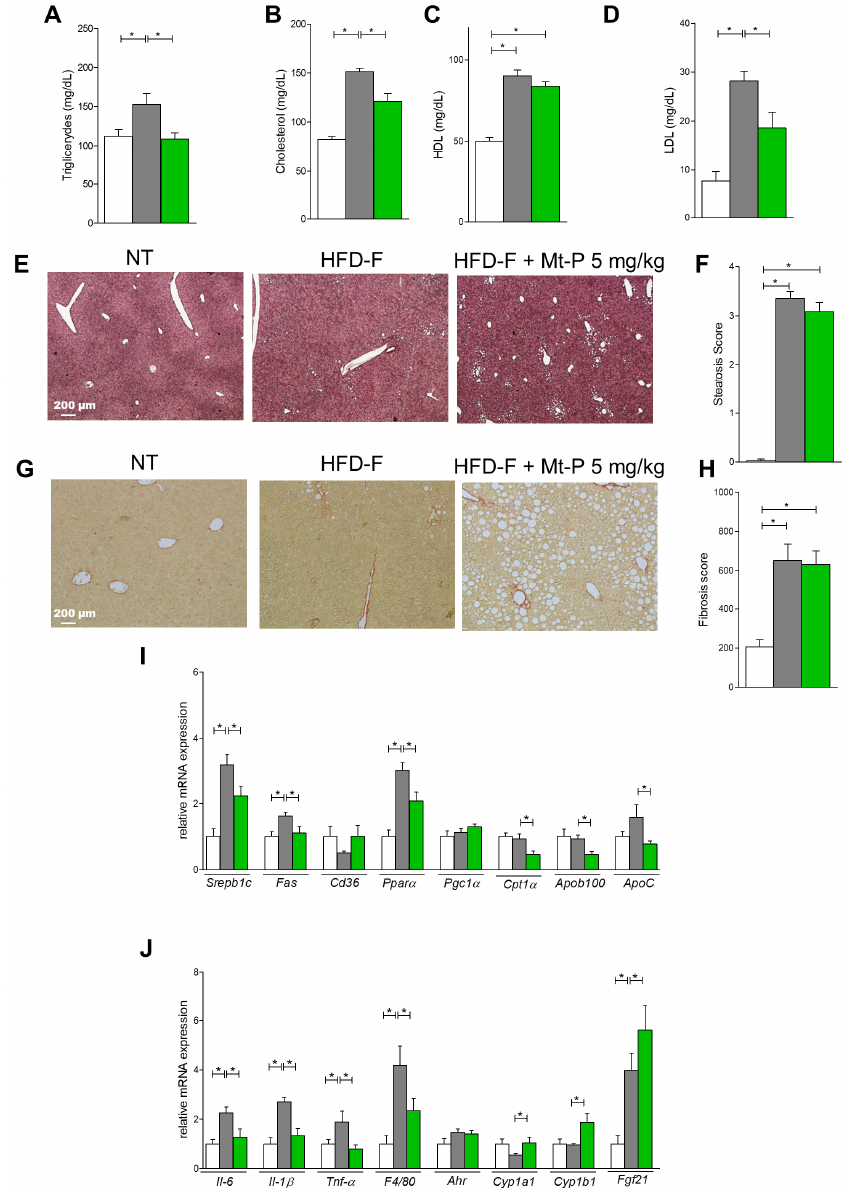
Figure 9. AhR activation exacerbated NASH-like features and fibrosis induced by HFD-F exposure. C57BL/6 male mice were fed a high fat diet (HFD) and fructose or normal chow diet as described before (see Section 2). Serum levels of ( A ) cholesterol, ( B ) triglycerides, ( C ) high density lipoproteins (HDLs), and ( D ) low density lipoproteins (LDLs). Biochemistry values were measured at the end of the study. ( E ) Hematoxylin and eosin (H&E) staining of liver tissues obtained at the end of the study (Magnification 4×). NASH severity was scored by assessing the ( F ) steatosis (NAS) score in at least five different fields per liver in a blind manner. ( G ) Sirius red staining of liver tissues obtained at the end of the study (Magnification 10×). ( H ) Liver fibrosis score (% collagen deposition) was measured, as described in Material and Methods, by ImageJ analysis. The images shown in panels ( E – H ) are representative of at least 10 others, each one obtained from an individual mouse, showing a similar pattern of regulation. Hepatic expression of ( I ) genes involved in the regulation of lipid synthesis ( Srebp1c, Fas ), fatty acids oxidation ( Ppar α , Pgc1 α , Cpt1 α ), and very low-density lipoprotein (VLDL) formation ( Apo100B, ApoC ), and ( J ) pro-inflammatory genes ( Il-6, Tnf α , Il-1 β , F4 / 80 ) and Ahr-target genes ( Ahr, Cyp1a1, Cyp1b1, Fgf21 ). Values are normalized relative to Gapdh mRNA and are expressed as mean ± SEM of six / ten mice per group (NT = 6; HFD-F = 8; HFD-F + Mt-P 5 mg / kg = 10) (* p <